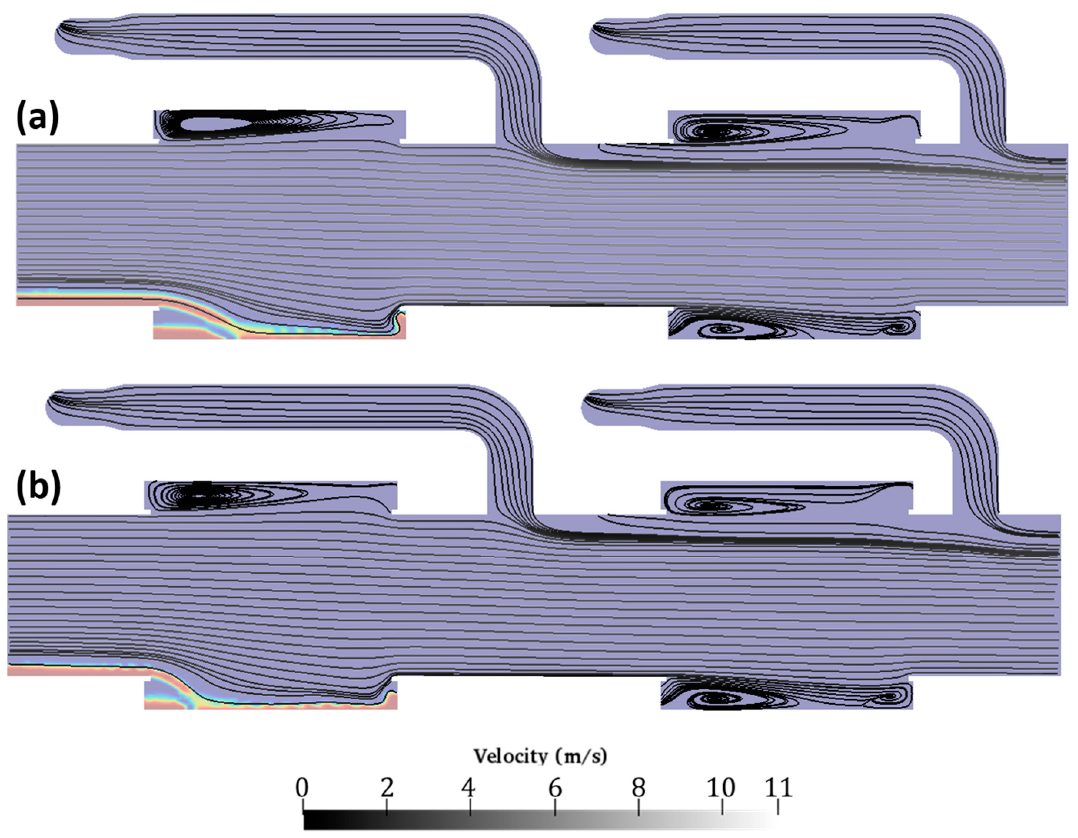
Figure 12. RANS-based instantaneous velocity streamlines for cases ( a ) case 6 (i.e. U G = 4.79 m/s and U L = 1.16 m/s), and ( b ) case 9 (i.e. U G = 2.72 m/s and U L = 0.48 m/s) for the manifold geometry. The background indicates the liquid (red) and gas (blue). The contour line maps locations’ flow separation.